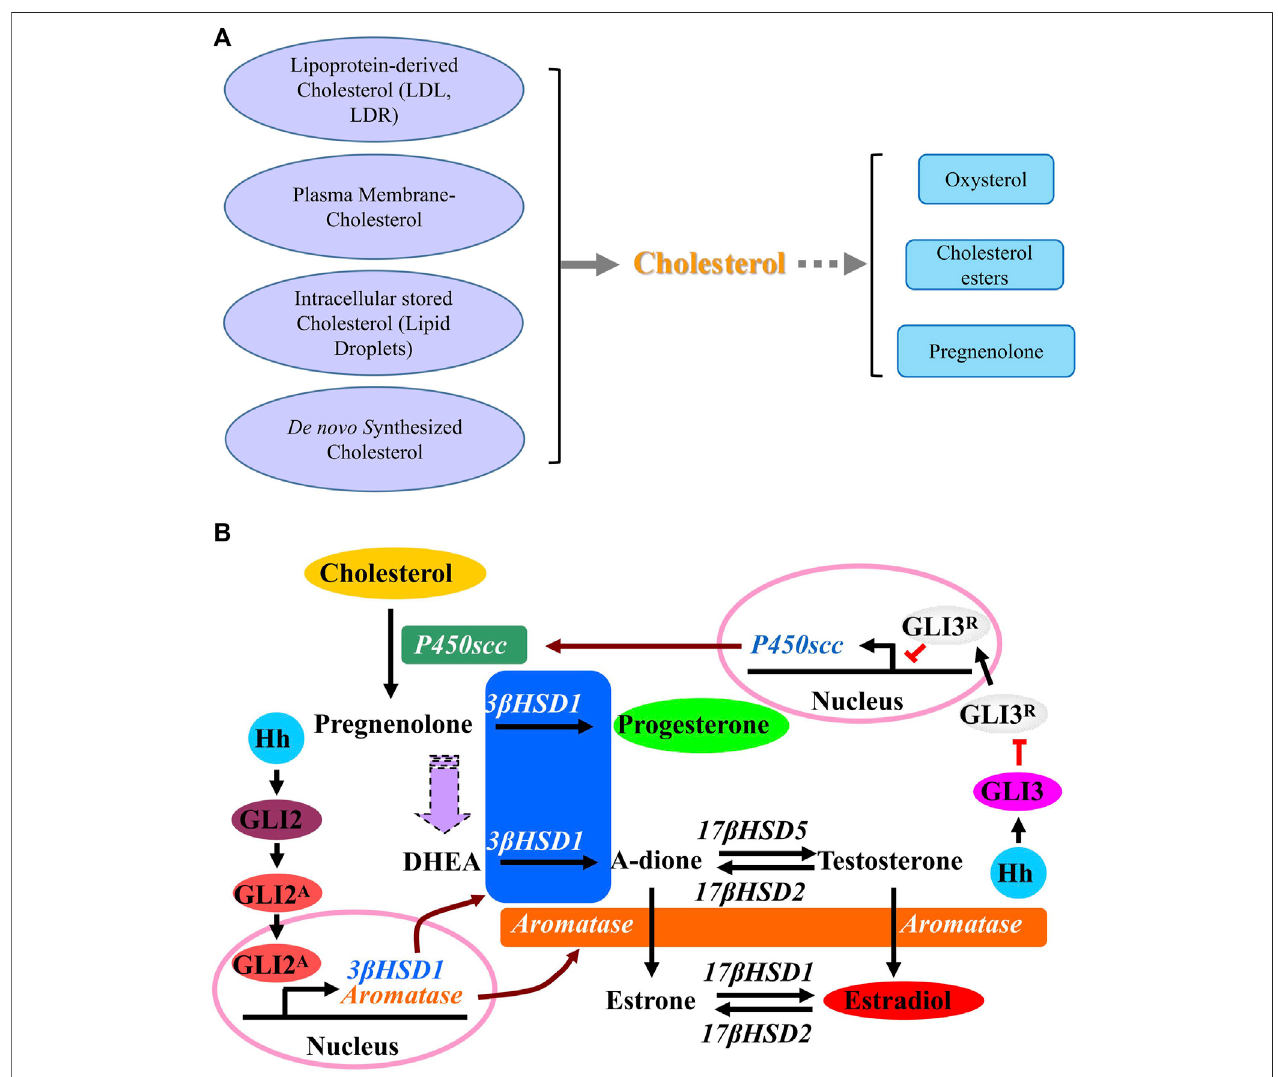
FIGURE 3 | Cholesterol synthesis pathways. (A) A schematic description showing the sources of cholesterol and the products of cholesterol. (B) A schematic description of effect of Hedgehog signaling on metabolism of cholesterol. Activation of Hh signaling induces the conversion of cholesterol to progesterone (P4) and estradiol (E2) through up-regulating the expression of steroidogenic enzymes including P450scc, 3 β -HSD1 and aromatase. GLI3 is required for Hh-induced P450scc expression, while GLI2 mediates the induction of 3 β -HSD1and aromatase. Abbreviations: P450scc, P450 cholesterol side chain cleavage enzyme; 3 β -HSD1, 3 β - hydroxysteroiddehydrogenasetype1;17 β -HSD1,17 β -hydroxysteroiddehydrogenasetype1;17 β -HSD2,17 β -hydroxysteroiddehydrogenasetype2;17 β -HSD5,17 β - hydroxysteroid dehydrogenase type 5; DHEA, Dehydroepiandrosterone.